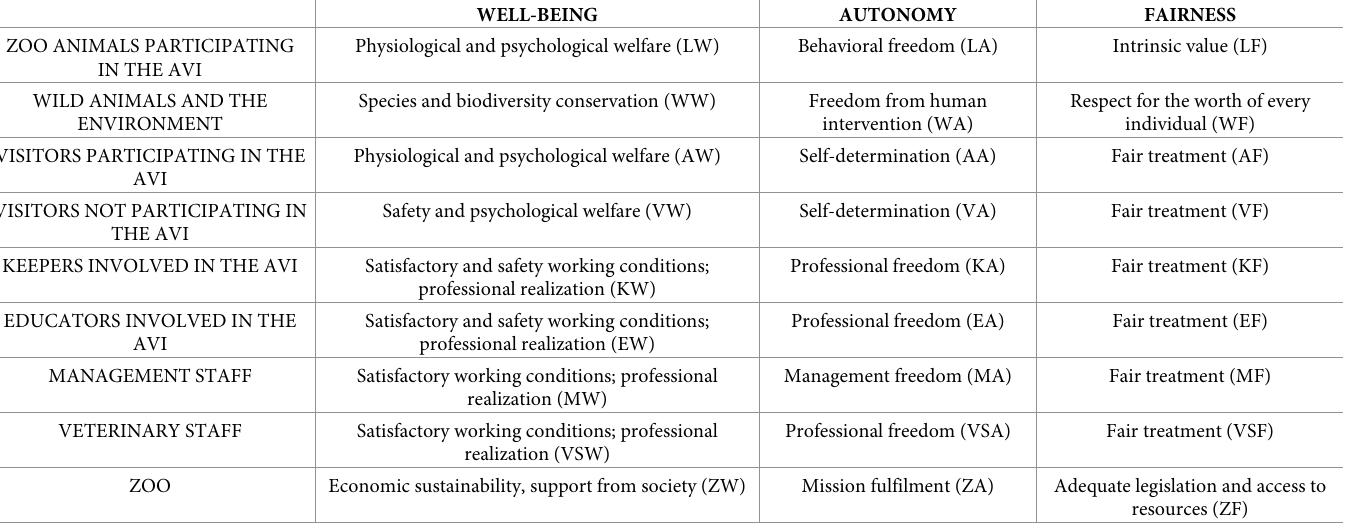
Table 7. Outline of the customized ethical matrix. Adapted from